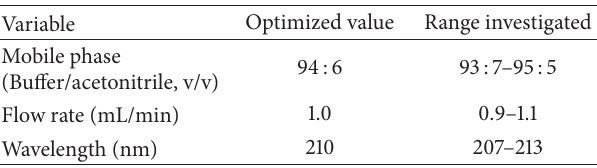
Table3:Investigatedrangeofexperimentalvariablesduringrobust- ness